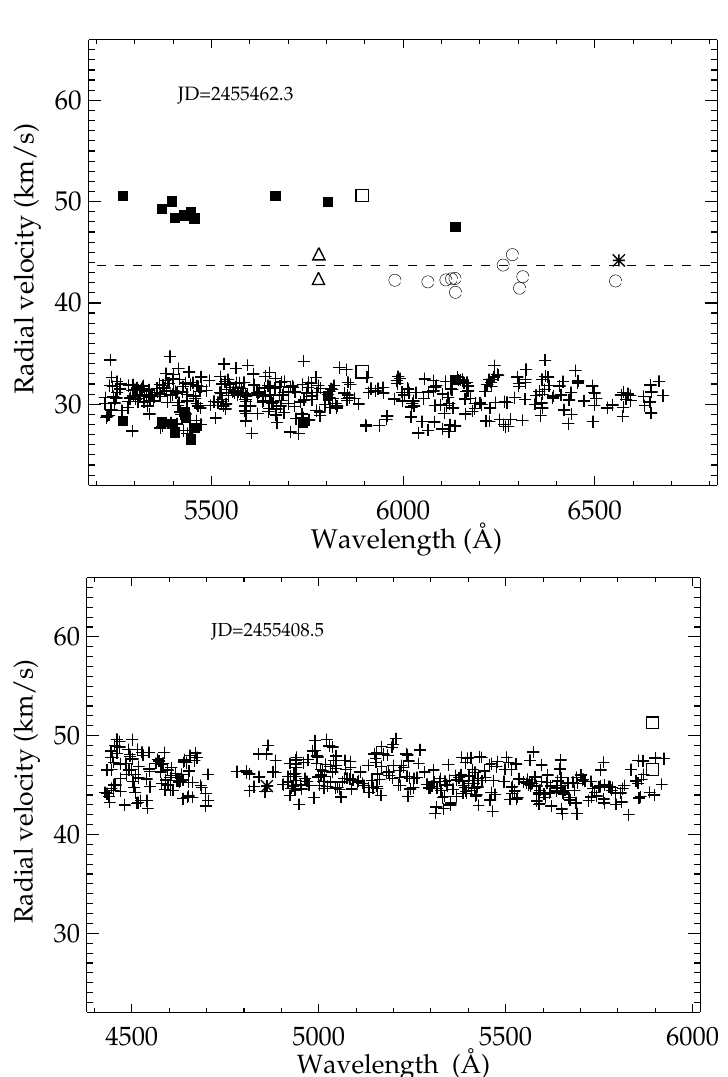
Fig. 9. Radial velocities measured in the SAO spectra of R Sct on two different dates. Crosses correspond to symmetrical absorptions, star symbols – to H I lines, dark squares – to the red and blue components of the spit metallic absorptions, open squares – to the photospheric components of D-lines, open circles – to Fe I emissions, and open triangles – to DIBs. The broken horizontal line corresponds to the velocity of the star’s